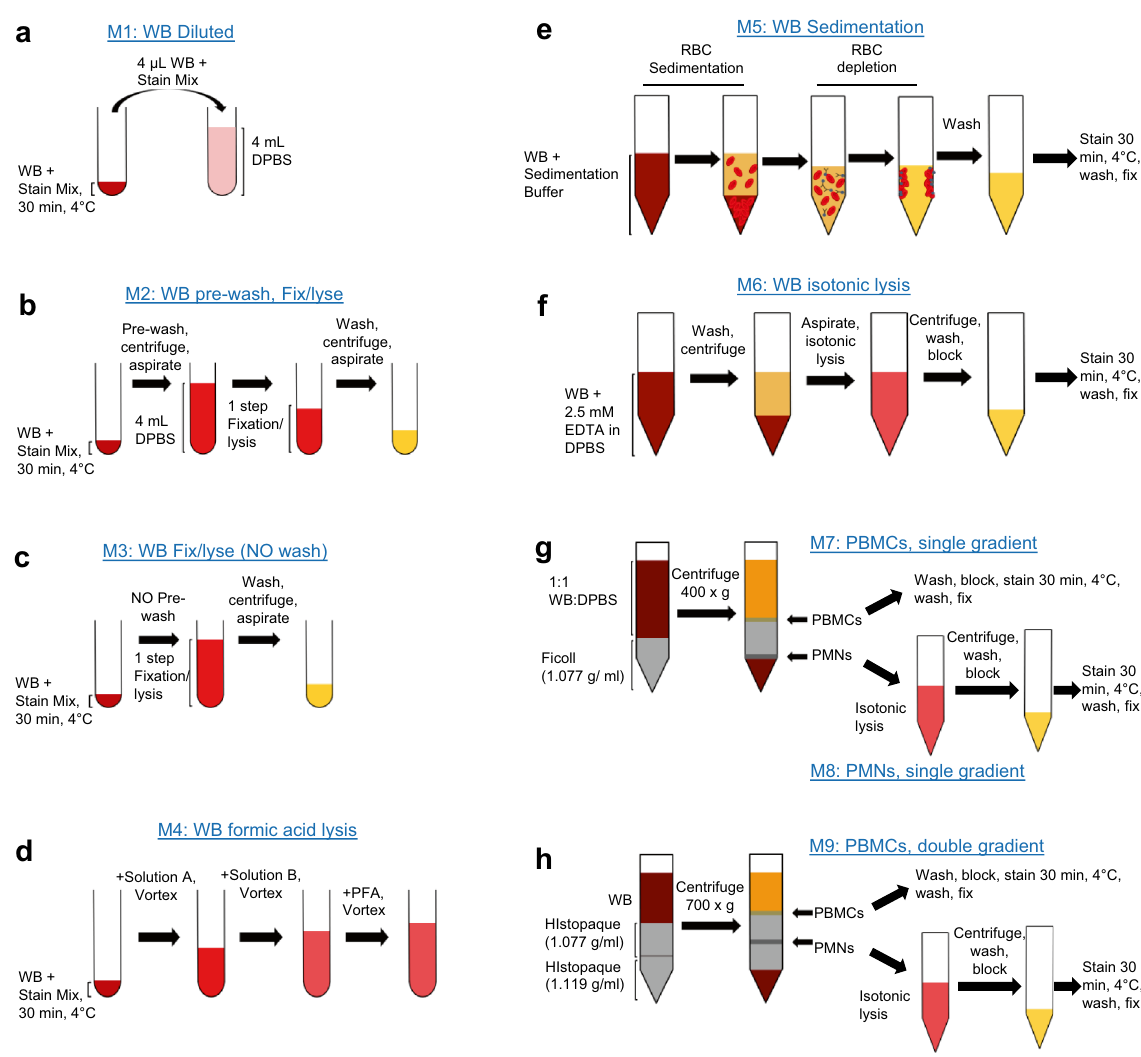
Figure 1. Neutrophil characterization methods. Schematic representations of tested methods. ( a ) Method M1; WB staining and dilution. ( b ) Method M2; whole blood staining followed by pre-washing antibodies and 1-step fixation and RBC lysis. ( c ) Method M3; WB staining followed by 1-step fixation and RBC lysis without pre-washing antibodies. ( d ) Method M4; WB staining followed by formic acid lysis and PFA fixation. ( e ) Method M5; RBC sedimentation of WB, followed by RBC depletion by magnetic beads, staining, washing, and fixation. ( f ) Method M6; isotonic lysis, followed by washing, staining, washing, and fixation. ( g ) Methods M7 and M8; WB dilution and single layer discontinuous density gradient centrifugation using Ficoll (1.077 g/ ml). PBMCs localize above the gradient and are processed as M7 (top part of panel): cells are washed, blocked, stained, washed, and fixed. PMNs localize below the gradient and are processed as M8 (bottom part of panel): after PBMC collection, the remaining Ficoll is removed, cells are isotonically lysed, washed, blocked, stained, washed, and fixed. ( h ) Methods M9 and M10; WB is layered on a double layer discontinuous density gradient of histopaque (top layer—1.077 g/ml and bottom layer—1.119 g/ml) and centrifuged. PBMCs localize at the intersection of the plasma and the top gradient and are processed as M9 (top part of panel): cells are collected, washed, blocked, stained, washed, and fixed. The PMNs localize at the interface between the two gradients and are processed as M10 (bottom part of panel): any remaining upper gradient is removed and cells are isotonically lysed, washed, blocked, stained, washed, and fixed. All samples are analyzed by multiparametric flow